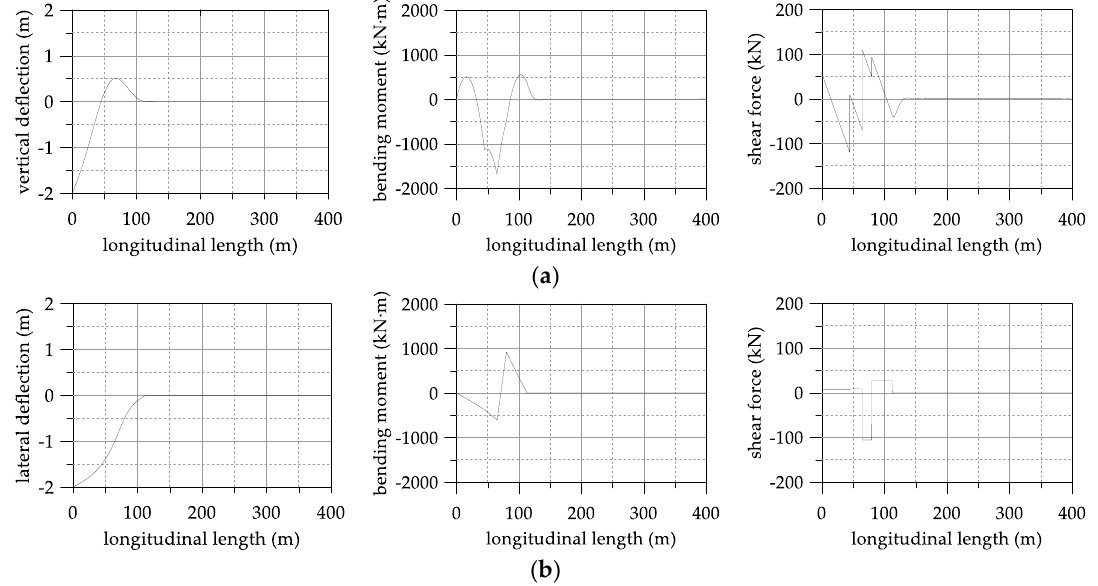
Figure 11. Analysis results of Case 3: ( a ) vertical plane (x-y plane); ( b ) lateral plane (x-z plane).